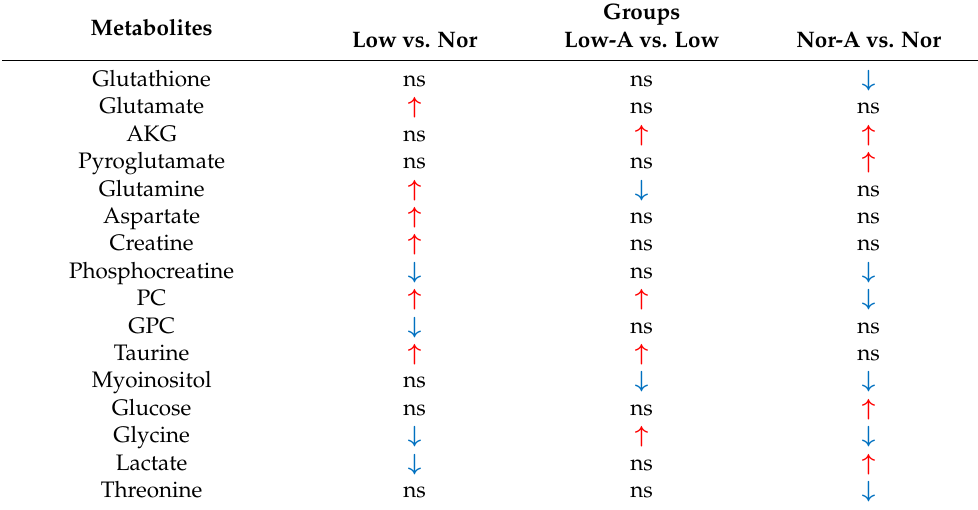
Table 1. Characteristic metabolites between the four groups of C2C12 myoblasts.